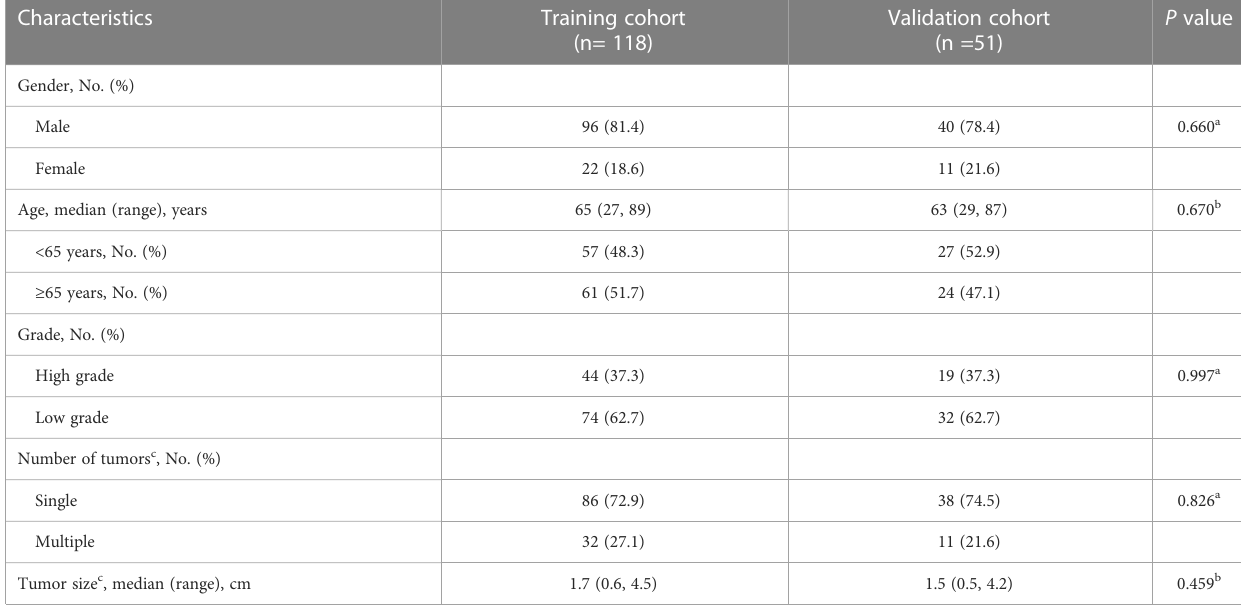
TABLE 1 The baseline demographics and clinical characteristics of patients in the training and validation cohorts.